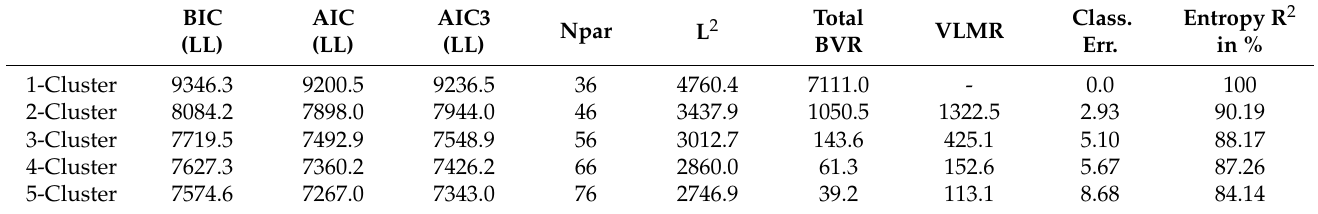
Table 1. Determining the number of the bullying exposure clusters: LCCA fit